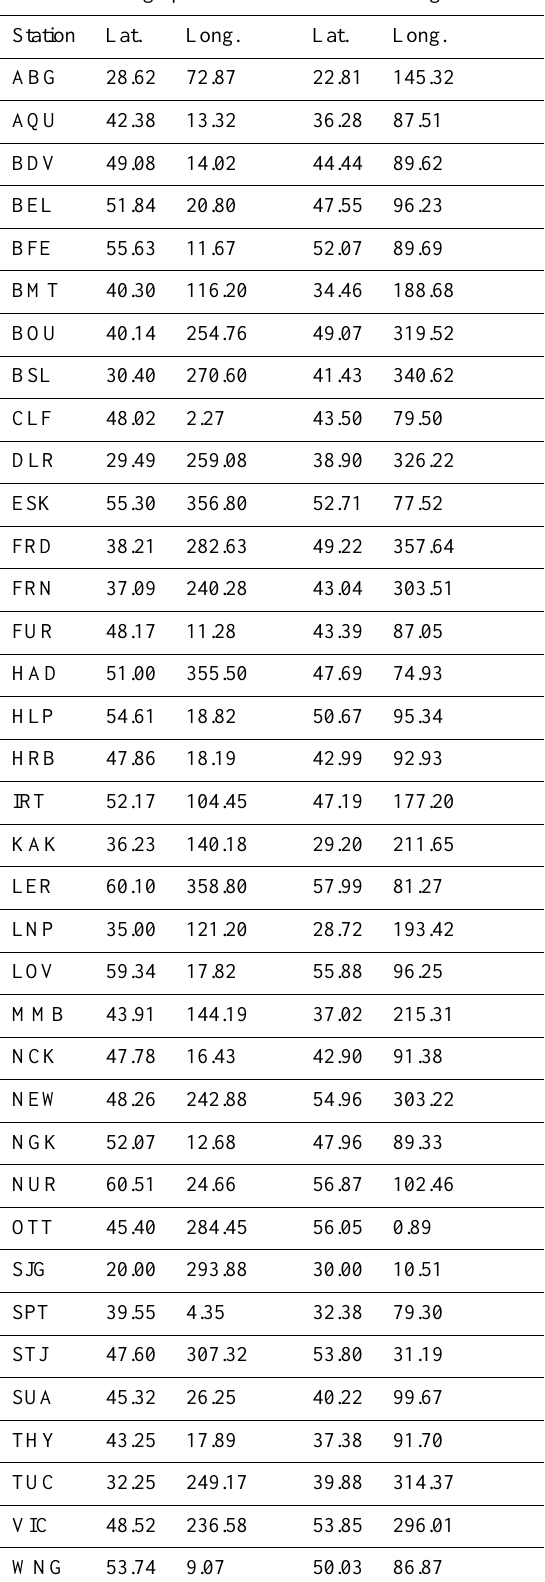
Table 1. List of geomagnetic observatories with geographic and corrected geomagnetic coordinates.